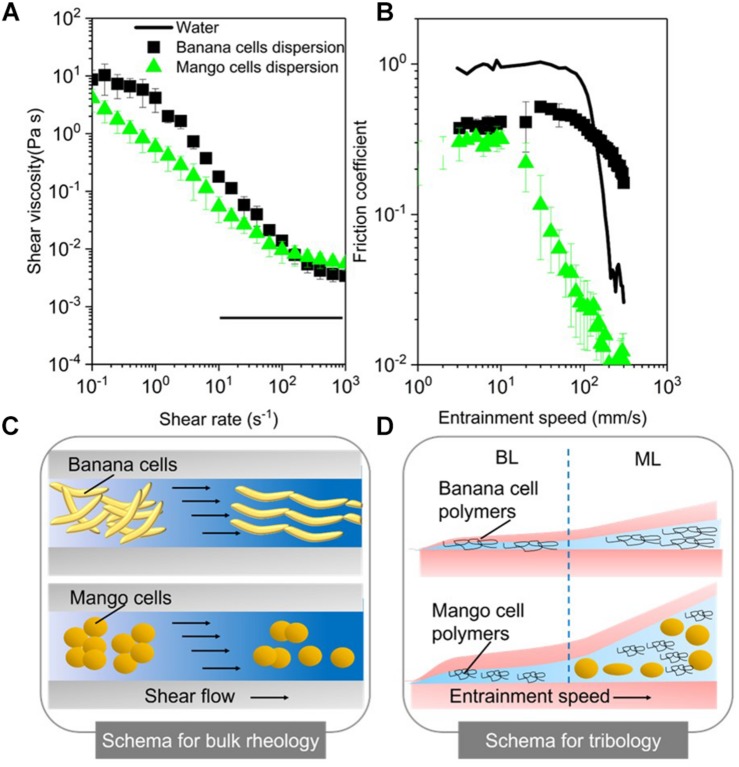
Apparent viscosities as a function of shear rates (A) and friction coefficients as a function of entrainment speeds (B) for mango and banana cell suspensions with respective schematics displayed for rheology (C) and tribology phenomena (BL, Boundary lubrication regime; ML, mixed lubrication regime) (D). MilliQ water was used as a control in both rheology and tribology experiments. Error bars represent the standard deviation of at least three measurements.